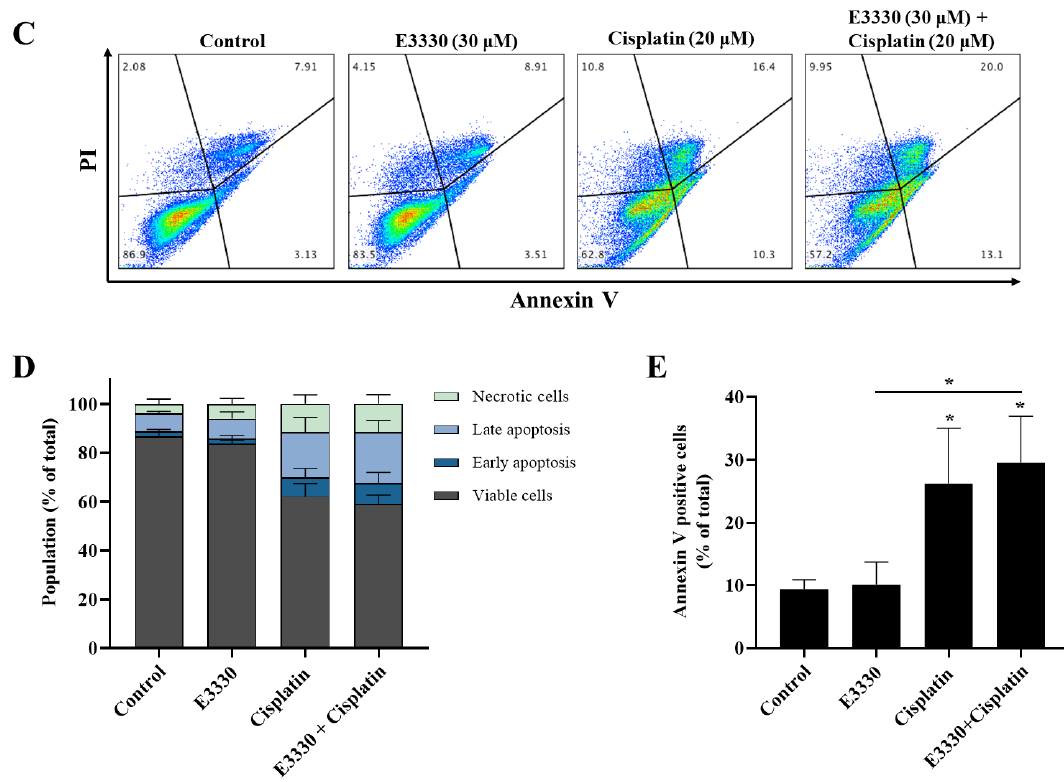
Figure 5. Cell cycle progression and apoptosis of H1975 cells treated with E3330 and / or cisplatin. Cells were pre-incubated with E3330 (30 µ M) for 3 h and then cisplatin (20 µ M) was added for co-incubation for further 72 h. After this exposure period, cell DNA content analysis with PI staining was performed by flow cytometry. ( A ) Representative flow cytometry histograms. ( B ) Sub-G1, G0 / G1, S, and G2 / M populations’ summary results. The percentage of apoptotic cells was determined by PI and Annexin V staining after the same incubation profile as in the cell DNA content analysis. ( C ) Representative flow cytometry dot-plots. ( D ) Percentage of viable cells, cells undergoing early and late apoptosis, and necrotic cells summary results. ( E ) Summary results demonstrate the percentage of apoptotic cells (Annexin V positive cells). Values represent mean ± SD ( n = 3), * p < 0.05 (one-way ANOVA with Tukey’s test).